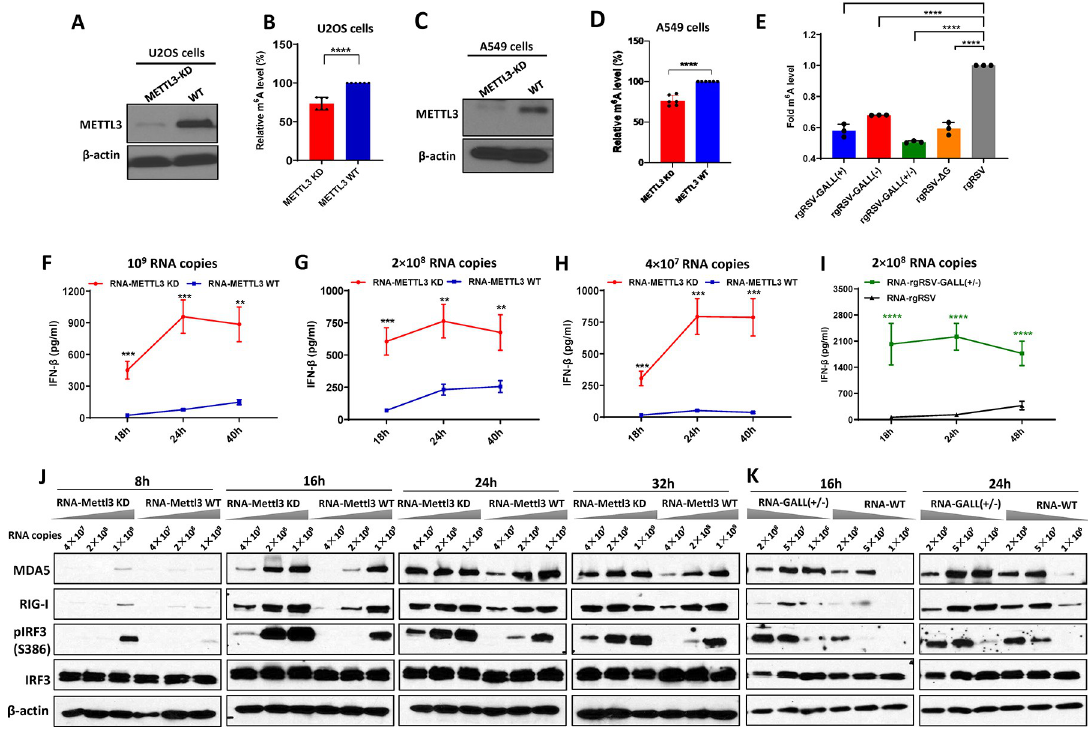
Fig 1. m 6 A-deficient virion RNAs induce higher type I IFN responses in cell culture. (A) Western blot showing METTL3 expression in METTL3 -knockdown (KD) U2OS cells and wild type U2OS cells. (B) Relative m 6 A level in virion RNA from RSV grown on METTL3 KD U2OS cells and wild type (wt) U2OS cells. The content of m 6 A level for each virion RNA was quantified by m 6 A methylation kit. (C) Western blot showing METTL3 expression in METTL3 -KD A549 cells and control sgRNA transduced A549 cells. (D) Relative m 6 A level in virion RNA from RSV grown on METTL3 -KD A549 cells and control sgRNA transduced A549 cells. (E) Relative m 6 A level in virion RNA from rgRSV mutants and wt rgRSV. rgRSV with G gene deletion mutant (rgRSV- Δ G), rgRSV-GALL(+), rgRSV-GALL(-), rgRSV-GALL(+/-), and rgRSV grew in HEp-2 cells and purified. The content of m 6 A level for each virion RNA was quantified. (F-H) A549 cells were transfected with 10 9 RNA copies (F), 2 × 10 8 RNA copies (G) and 4 × 10 7 RNA copies (H) of virion RNA of RSV grown on METTL3 -KD or WT cells, IFN- β was measured at indicated time points. (I) Comparison of IFN response virion RNA of rgRSV-GALL (+/-) and WT rgRSV. A549 cells were transfected with of 2 × 10 8 RNA copies of mutant virus and IFN- β was measured. (J and K) m 6 A- deficient RSV RNA increases expression of RIG-I and MDA5 and induces higher IRF3 phosphorylation. A549 cells were transfected with virion RNA of RSV grown on METTL3 KD/WT cells (J) at dose of 1.0 × 10 9 , 2 × 10 8 and 4 × 10 7 RNA copies, or virion RNA of rgRSV-GALL(+/-) and parental rgRSV (K) at dose of 2 × 10 8 , 5 × 10 7 , and 1 × 10 6 RNA copies. At indicated times, cell lysates were analyzed by Western blotting using antibodies specific to RIG-I, MDA5, IRF3, IRF3 (phosphorylated at S386) or β -actin. Data shown are mean ± s.d. of n = 6 (B, D) or n = 3 (E-I) independent experiments. Western blots are representative of n = 3 biologically independent experiments. Statistical significance was determined by two-sided Student’s t -test. � P < 0.05; �� P < 0.01; ��� P < 0.001; ���� P < 0.0001.